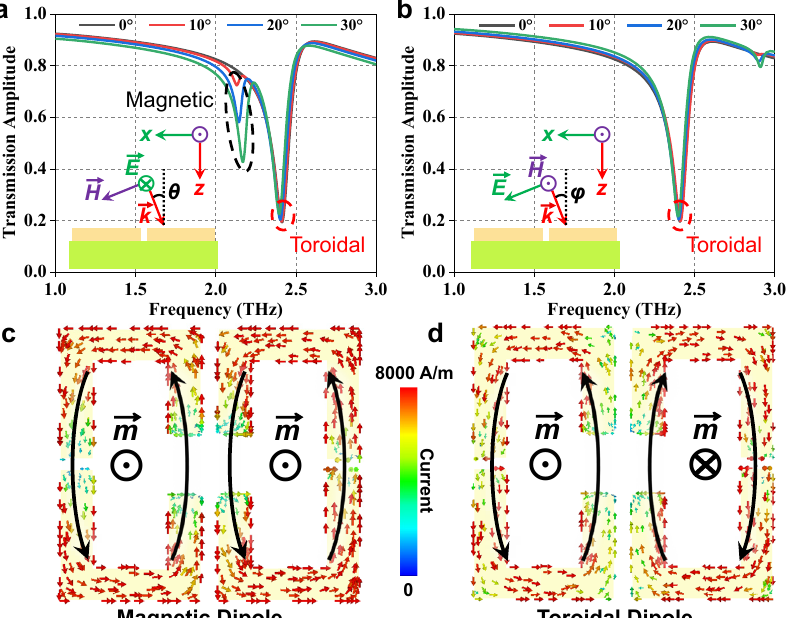
Figure 3: Transmission spectra of the toroidal metasurface under oblique illumi- nation for (a) transverse electric and (b) transverse magnetic modes. Simulated sur- facecurrentsfor(c)magneticand(d)toroidal resonances at 2.17 THz and 2.39 THz, respec-